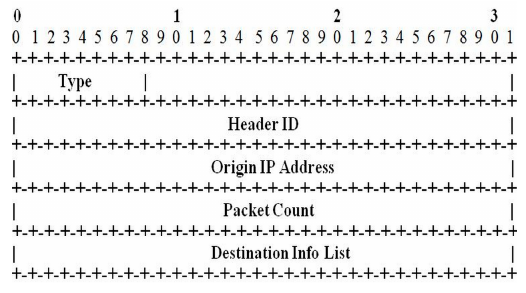
Figure 5. Delivery info control packet.